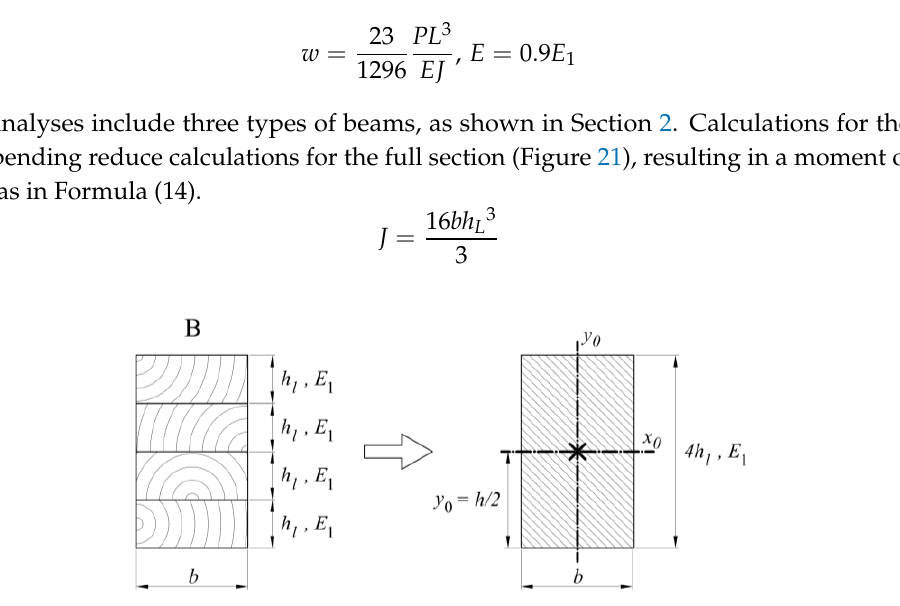
Figure 20. Laboratory tests results for full-scale girders.